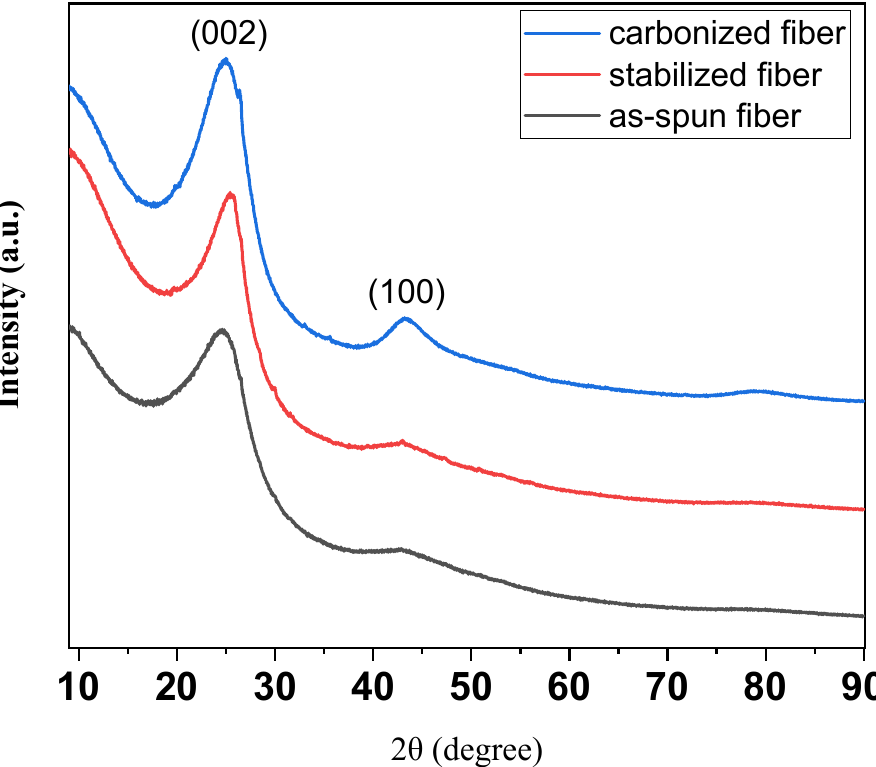
Figure 5. XRD patterns of as-spun fiber, stabilized fiber, and carbonized fiber from